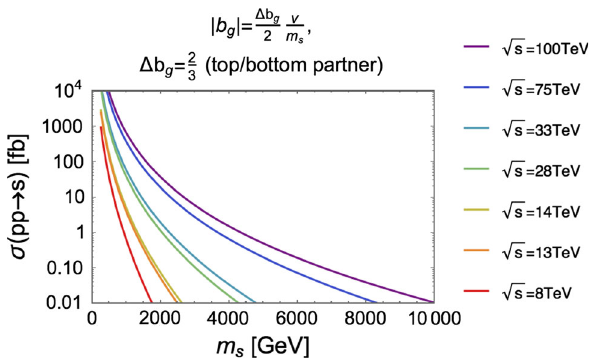
(cid:14) (cid:14) (cid:14) = (cid:5) b g (cid:14) b v with g m s 2 (cid:15) (cid:16) 2 ; see Eq. (22) (cid:5) b g